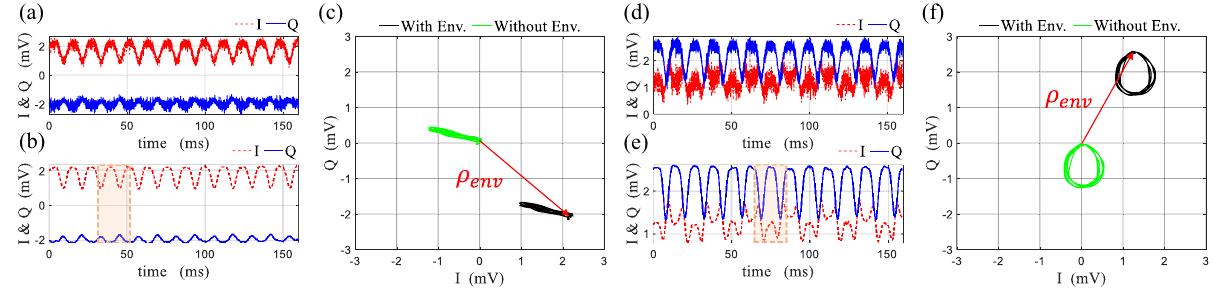
Figure 7. Obtained raw IQ data in measurement for scattering from ( a ) symmetrically, ( d ) non-symmetrically rotating rectangular loop, and the averaged IQ data for scattering from ( b ) symmetrically ( e ) non-symmetrically rotating rectangular loop. The measured IQ constellation diagram plotted based on the averaged data for ( c ) symmetrically ( f ) non-symmetrically rotating rectangular loop. The original measured modulation paths are shown in black color, and after the subtraction of the environment contribution (red arrow) they are shown in green color.